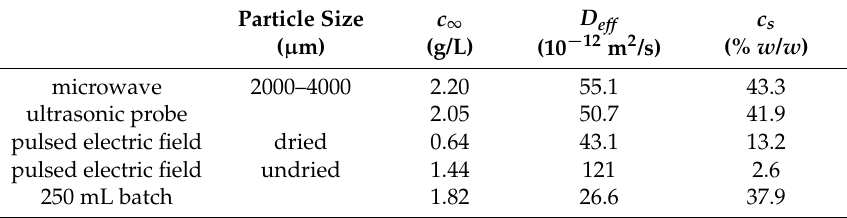
Table 5. Comparison of